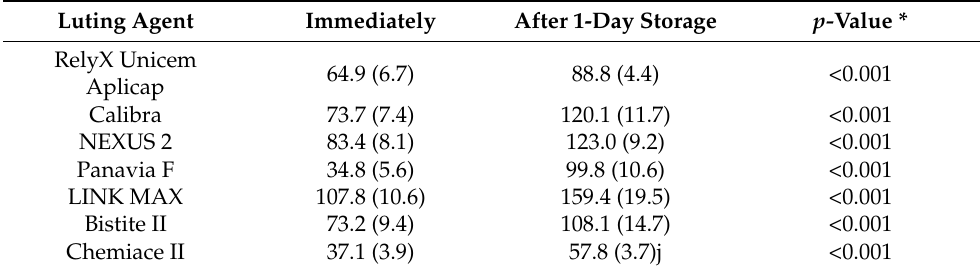
Table 2. Flexural strength of luting-agents (MPa, mean (S.D.)). Luting Agent Immediately After 1-Day Storage p- Value * RelyX Unicem Aplicap